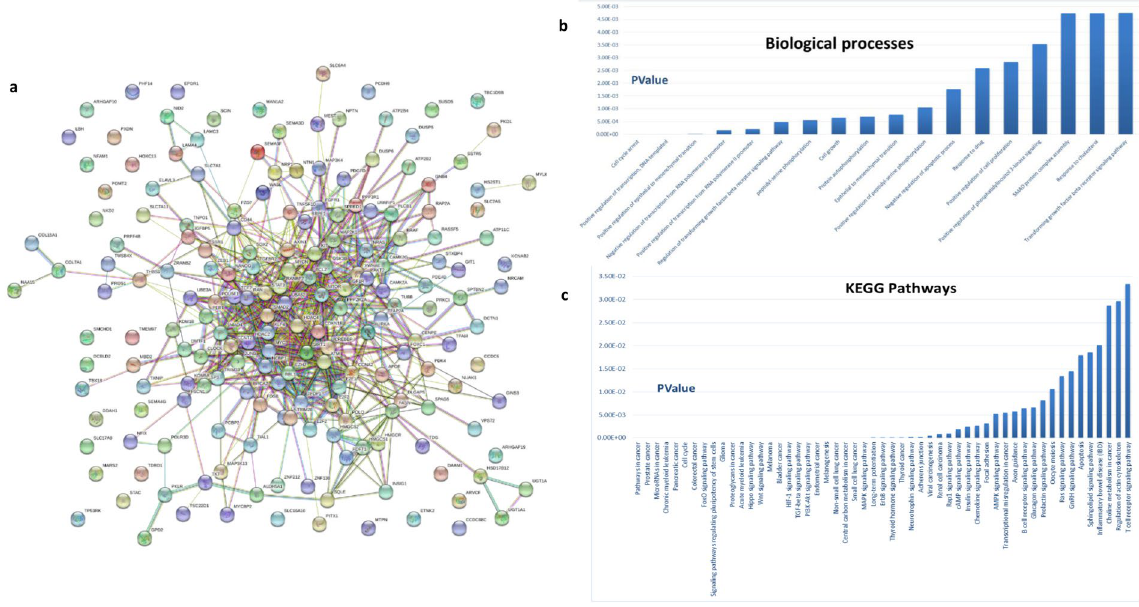
Figure 2. The functional enrichment analysis of the HCSC up-regulated target proteins. ( a ) STRING network. DAVID enrichment analysis represents the involved ( b ) biological processes (GO) and ( c ) pathways (KEGG).